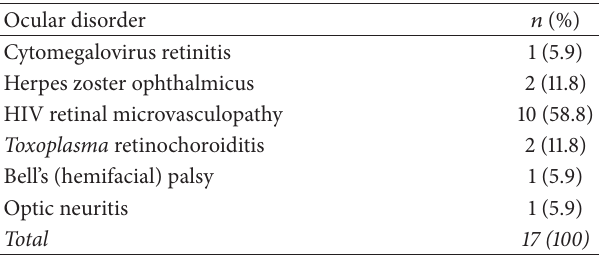
Table 1: Ocular disorders among